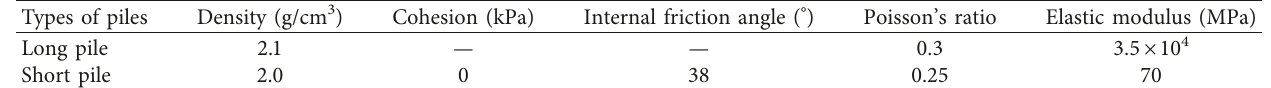
Table 4: Pile material parameters.